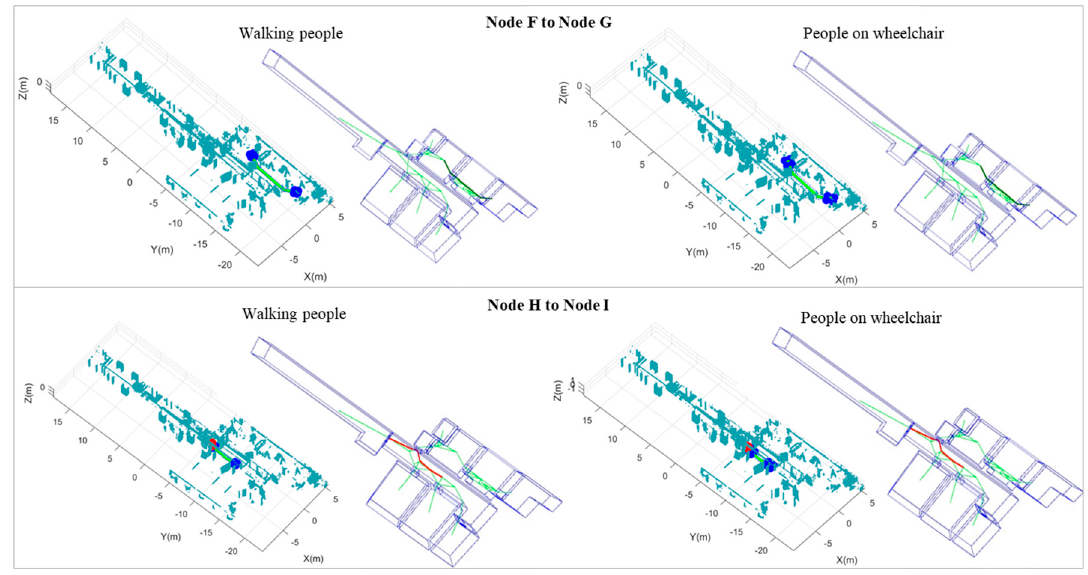
Figure 17. “Node F to Node G” and “Node H to Node I” tests are represented. While, in the first case, no obstacles were found, in the last case, the destination could not be reached due to the presence of people in the corridor detected as obstacles (units in meters).